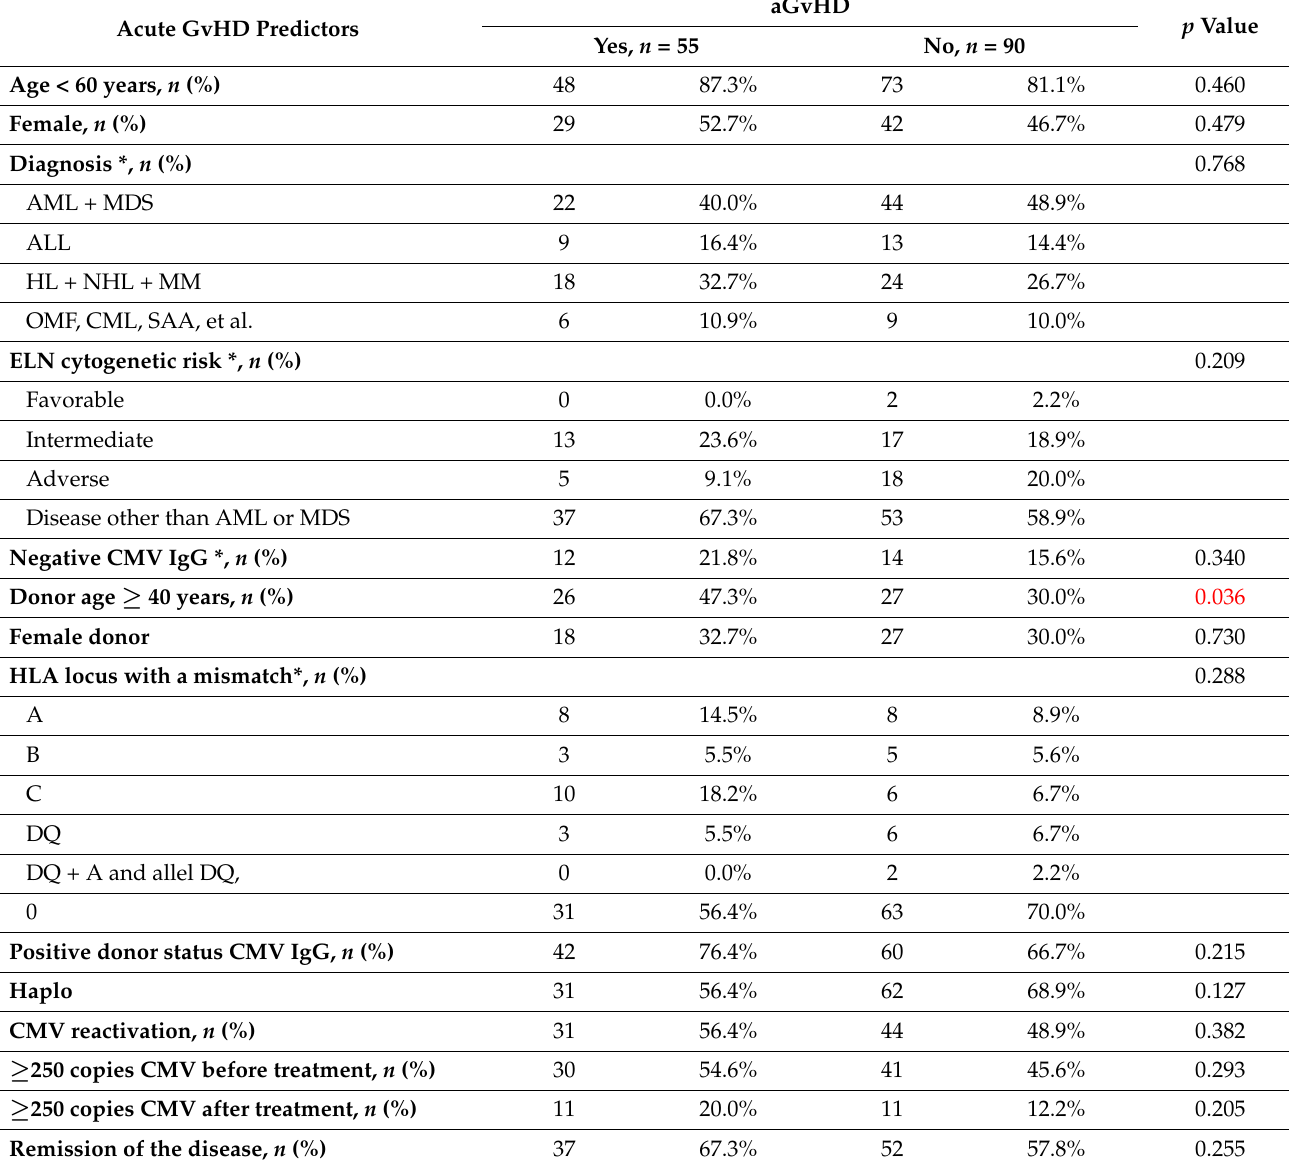
Table 3. The characteristics of patients differing by the presence of acute GvHD in a study population (in red: p <